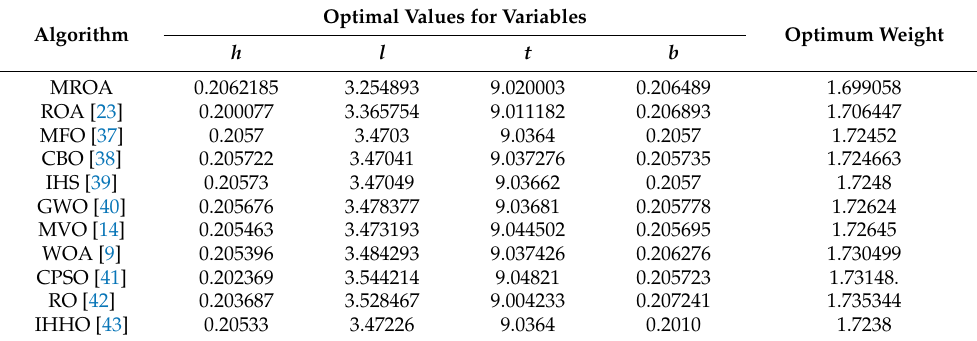
Table 11. Comparison of optimal solutions for the welded beam design problem.